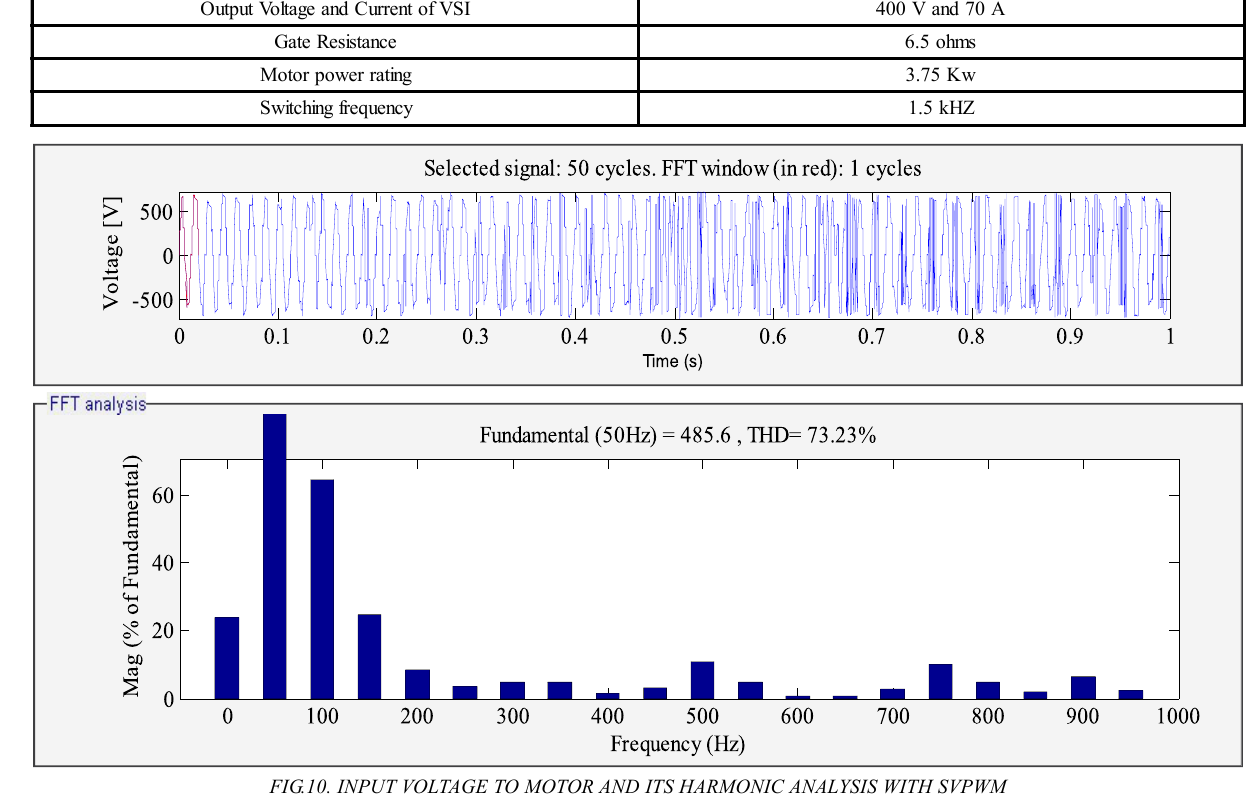
FIG.10. INPUT VOLTAGE TO MOTOR AND ITS HARMONIC ANALYSIS WITH